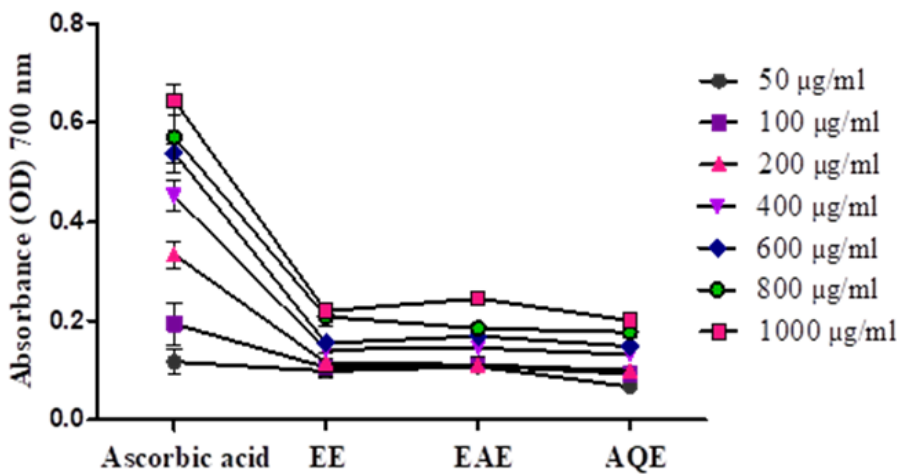
FIGURE 3 - Ferric reducing antioxidant power (FRAP) of ascorbic acids and different seed extracts (EE, EAE and AQE) of N. arbor-tristis